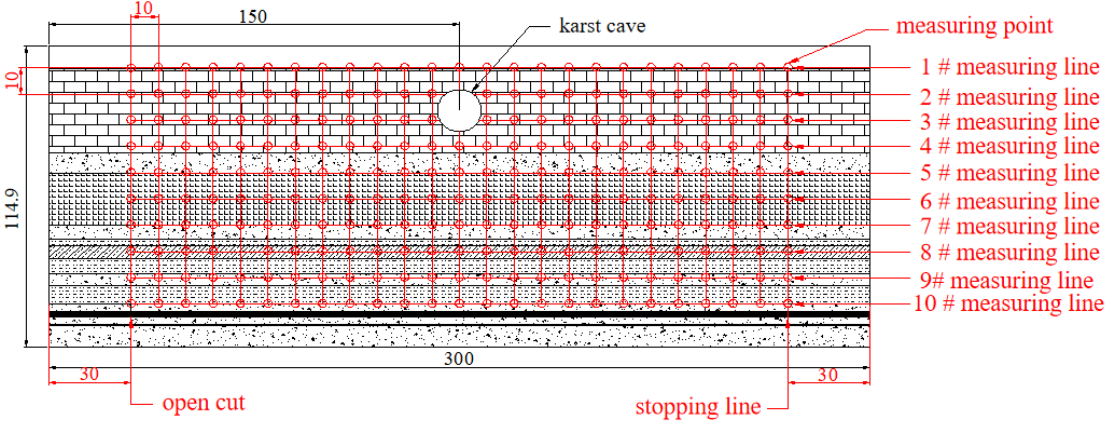
Figure 3. Model laying and monitoring line layout.